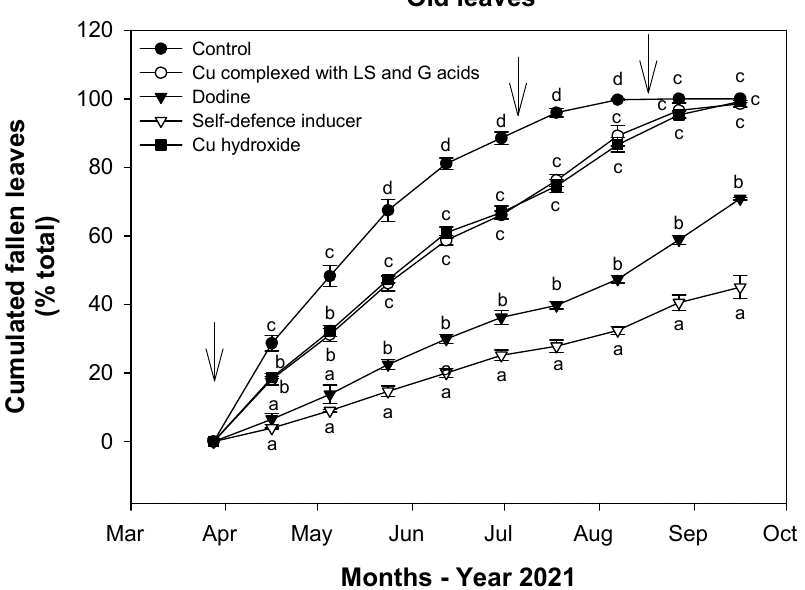
Figure 1. Effects of chemical treatments on the percentage of defoliation of old olive leaves (developed in 2020 and still present in 2021). The arrows indicate the dates of fungicide application. The bars represent the standard error. For each date, means followed by different letters are significantly different at p ≤ 0.05 .